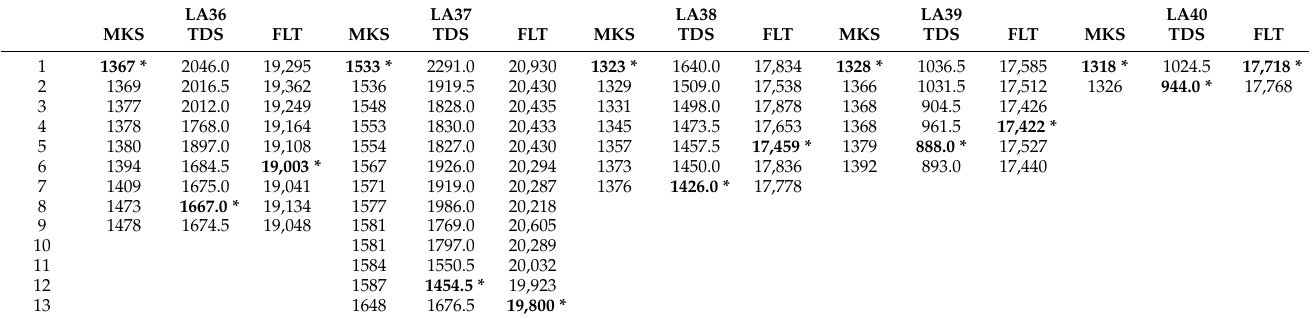
Table A17. Non-dominated solutions obtained by SS/CMOTA for the JSSP instances proposed by [38].